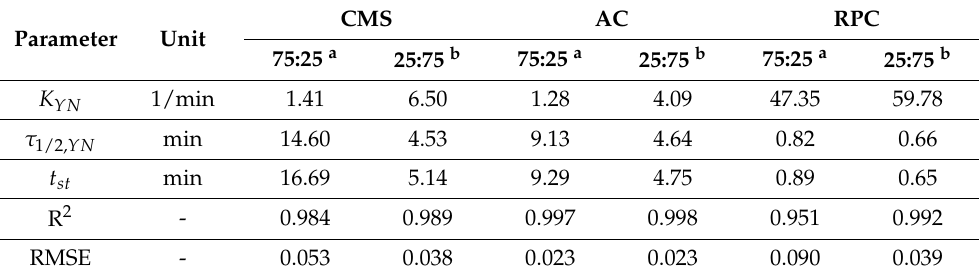
Table 2. Yoon–Nelson model parameters and the stoichiometric time for the investigated samples. Parameter